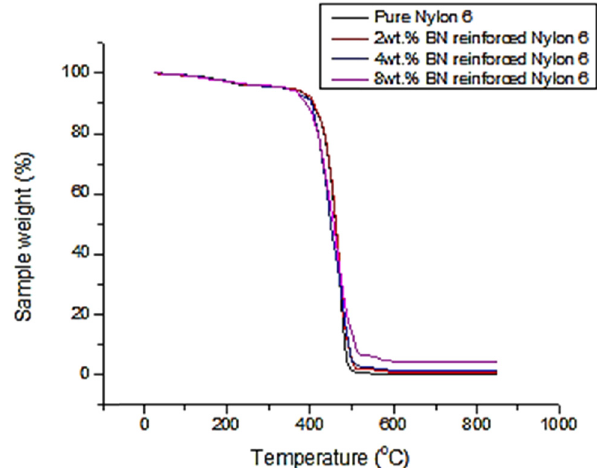
Figure 11: TGA plots of nylon 6 and nylon 6 composites.